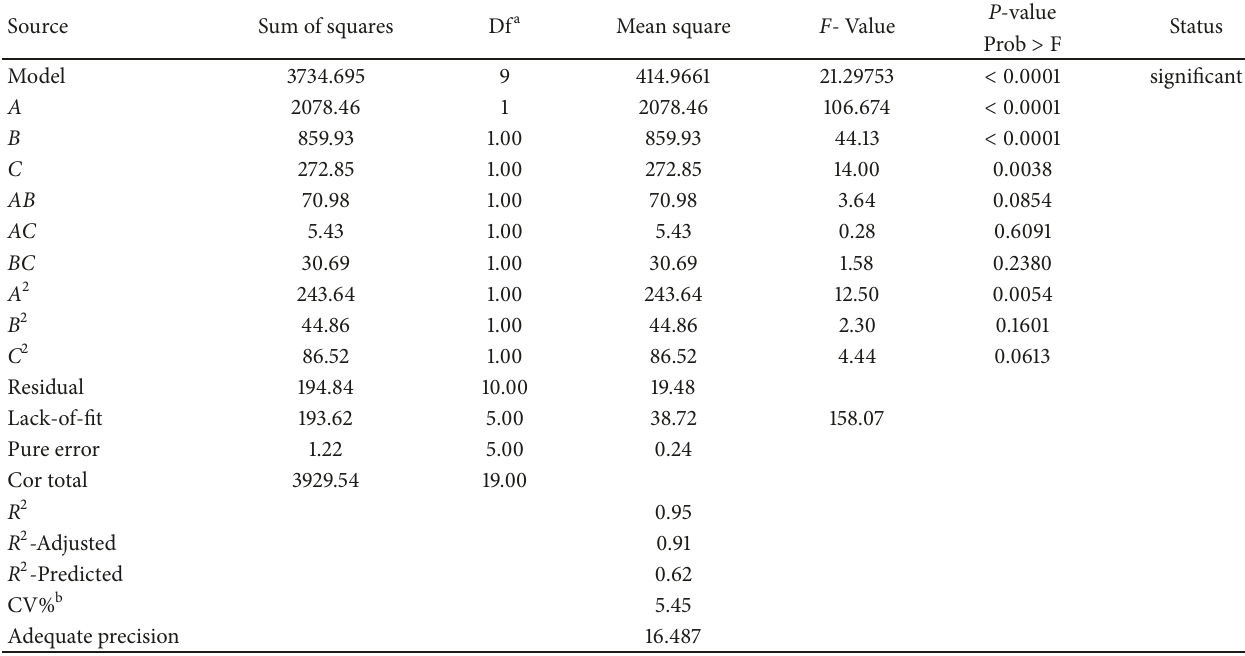
Table 8: ANOVA for BG